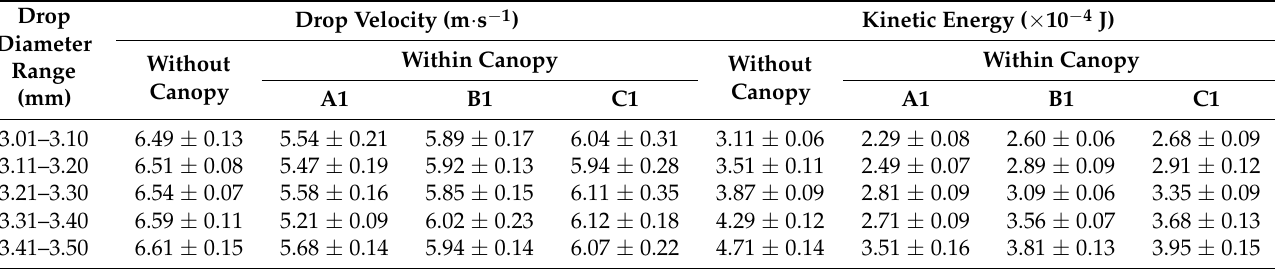
Within Canopy Canopy